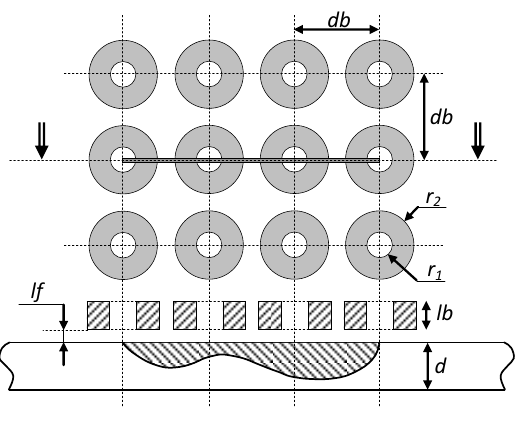
Figure 3. The modeled system.